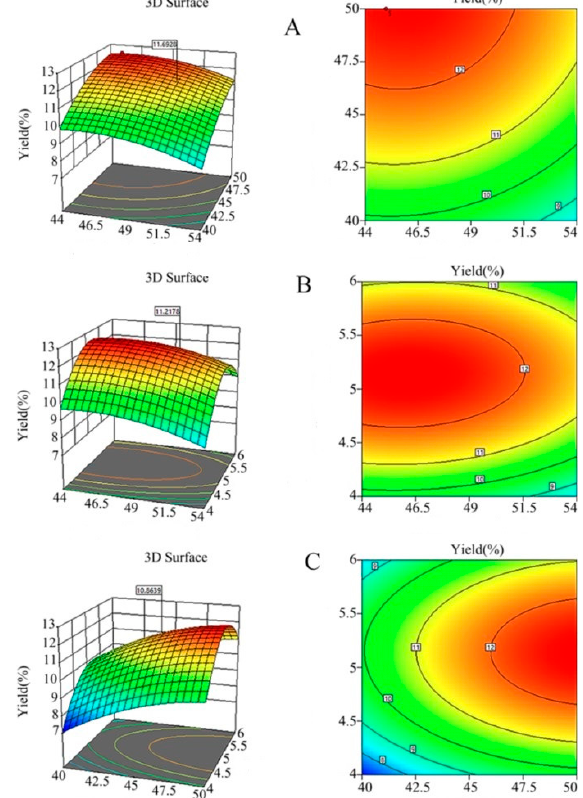
Figure 3. Effects of the ( A ) extraction time, ( B ) extraction temperature, and ( C ) material-to-liquid ratio on the Cers yield.